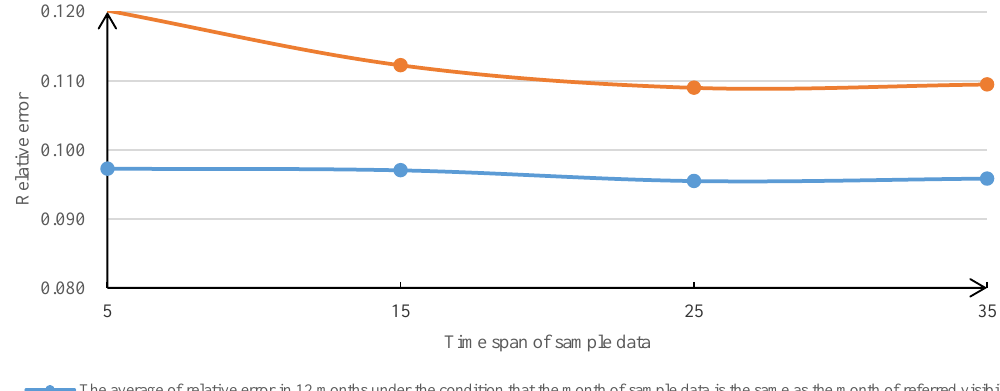
Figure 6. Average relative error of the 12 months under the above two sample data conditions, with sample data of 5-year data, 15-year data, 25-year data and 35-year data respectively.